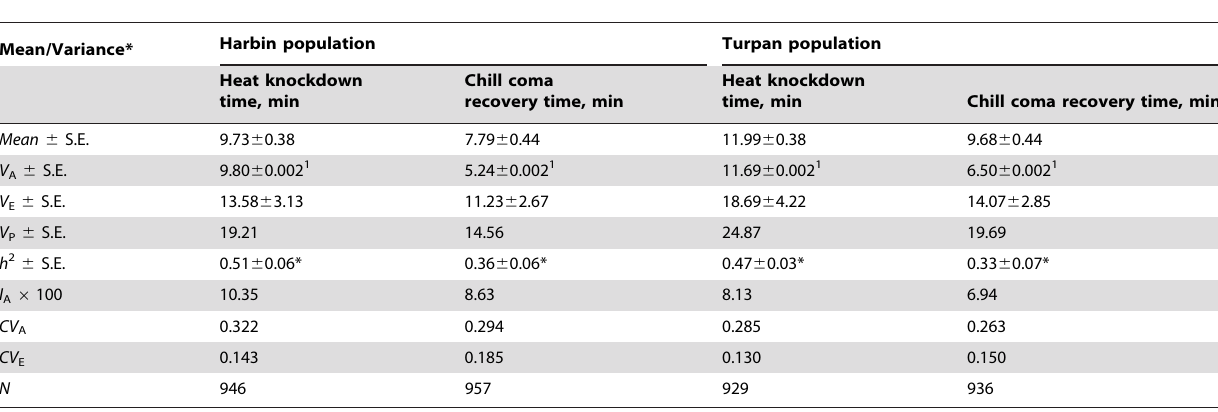
Table 3. Narrow-sense heritability ( h 2 ), variance, and coefficient of variation components for heat knockdown time and chill coma recovery time (Harbin and Turpan populations) of B. tabaci MED cryptic